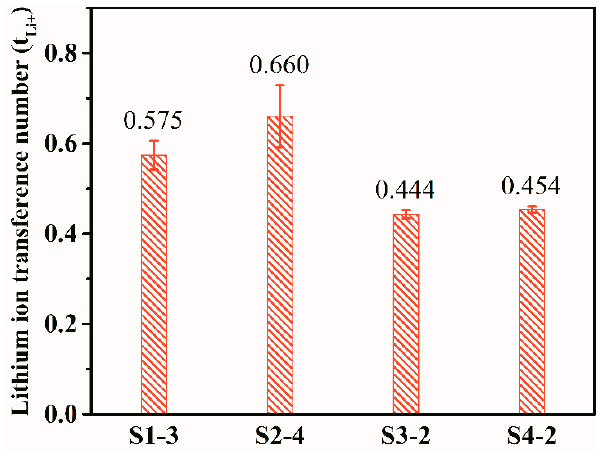
Figure 5. The lithium ion transference numbers of GPEs prepared by different mixing solvents.